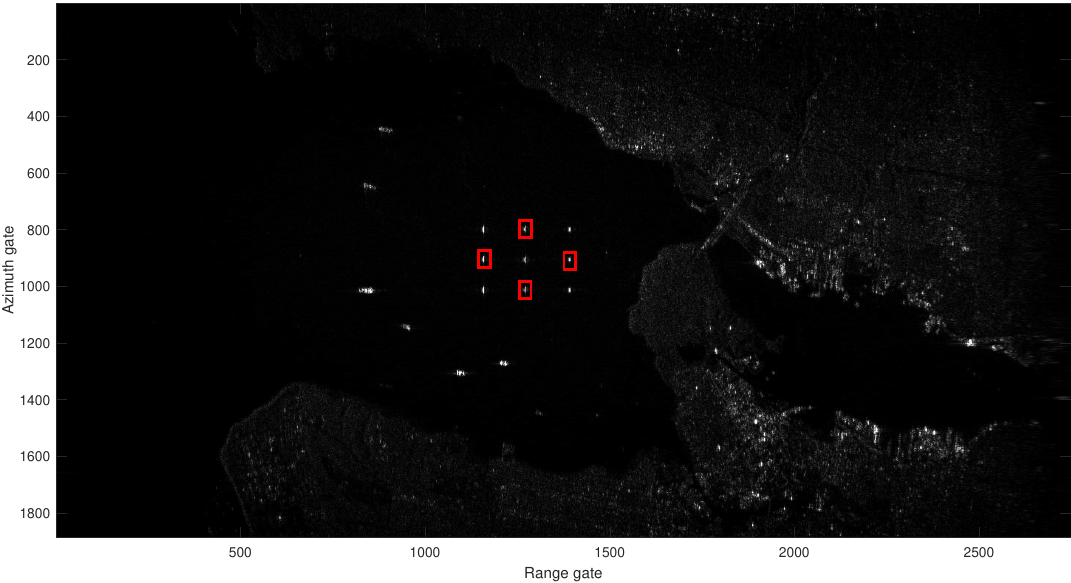
Figure 17. Ground truth scene containing the static clutter, five stationary targets and four targets with same cross-track velocity of v r = 5 m/s, and same along-track velocity of v a = 5 m/s. The red rectangle indicates the moving target. Table 3. Simulation parameters of five stationary targets and four moving